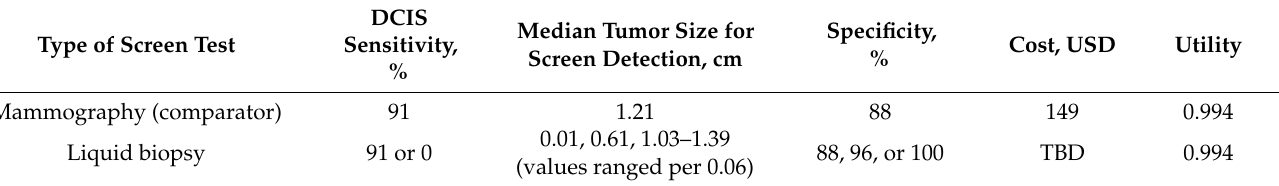
Table 1. Liquid biopsy test characteristics, costs, and utilities in routine screening.